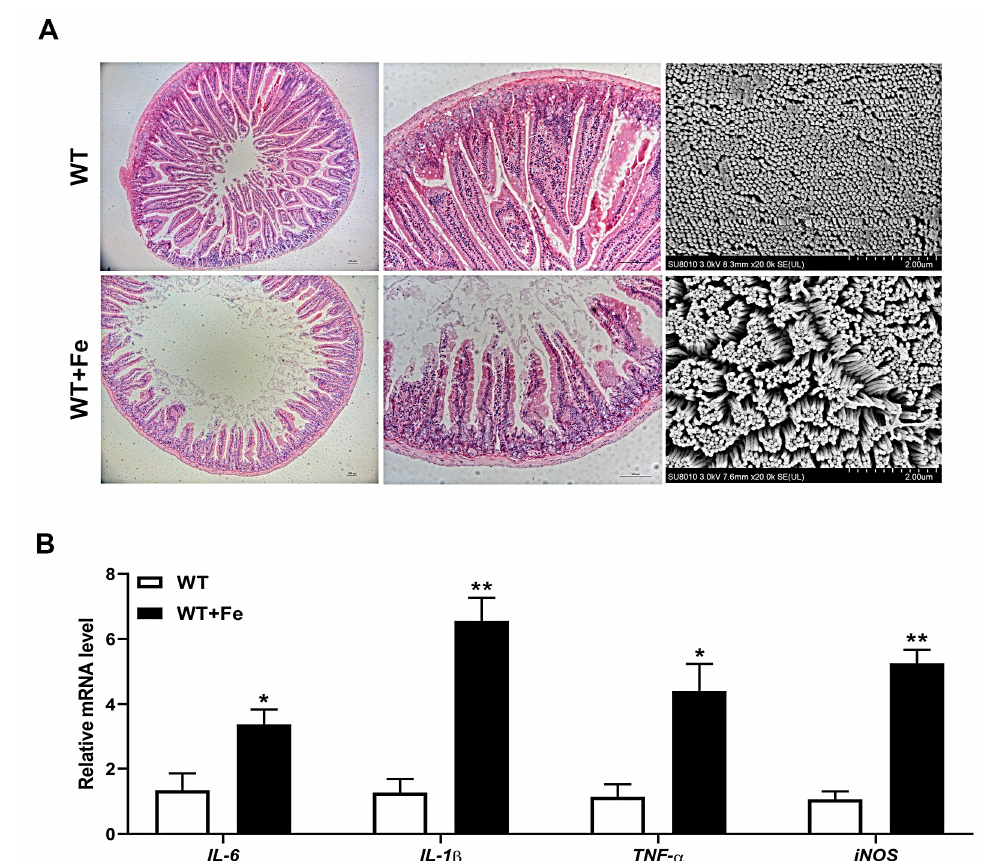
Figure 5. A high-iron diet induced intestinal damage of mice. ( A ) H&E staining and SEM of the duodenum. ( B ) IL-6 , IL-1 β , TNF- α and iNOS mRNA levels in the duodenum. Data are presented as the mean ± SEM. * p < 0.05, ** p <